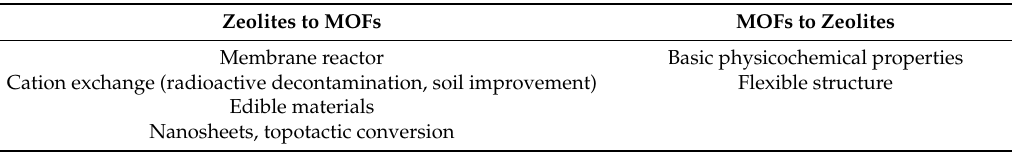
Table 3. Proposed research areas for zeolites and